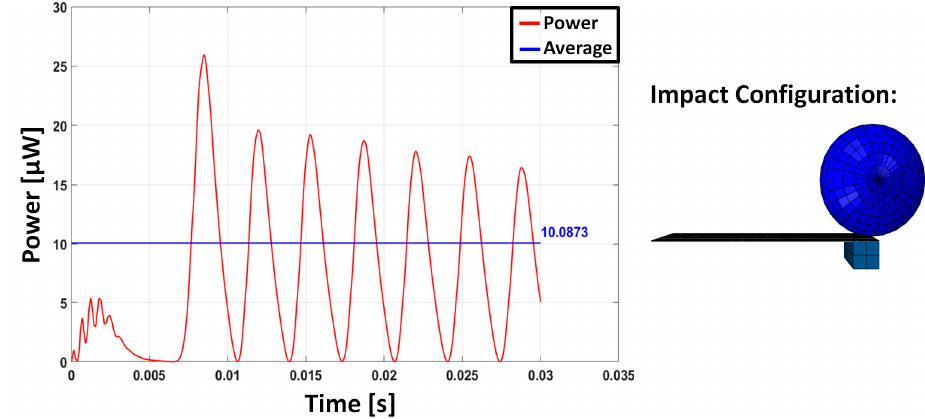
Figure 5. Instantaneous power and average value computed over a time duration of 30 ms in the case of TM10 with impact position L.